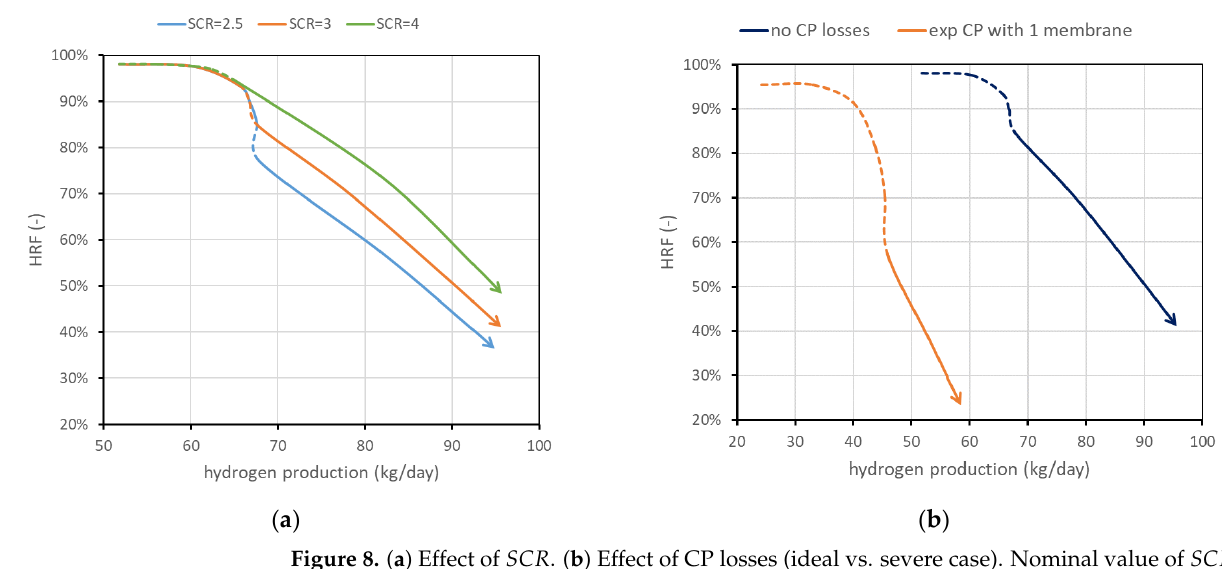
Figure 8. ( a ) Effect of SCR . ( b ) Effect of CP losses (ideal vs. severe case). Nominal value of SCR is 3 and CP losses are neglected.